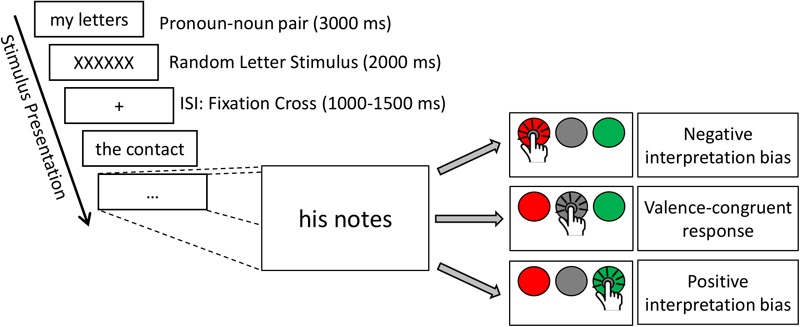
Time course of the experimental paradigm with different response types, illustrating positive, and negative interpretation biases.